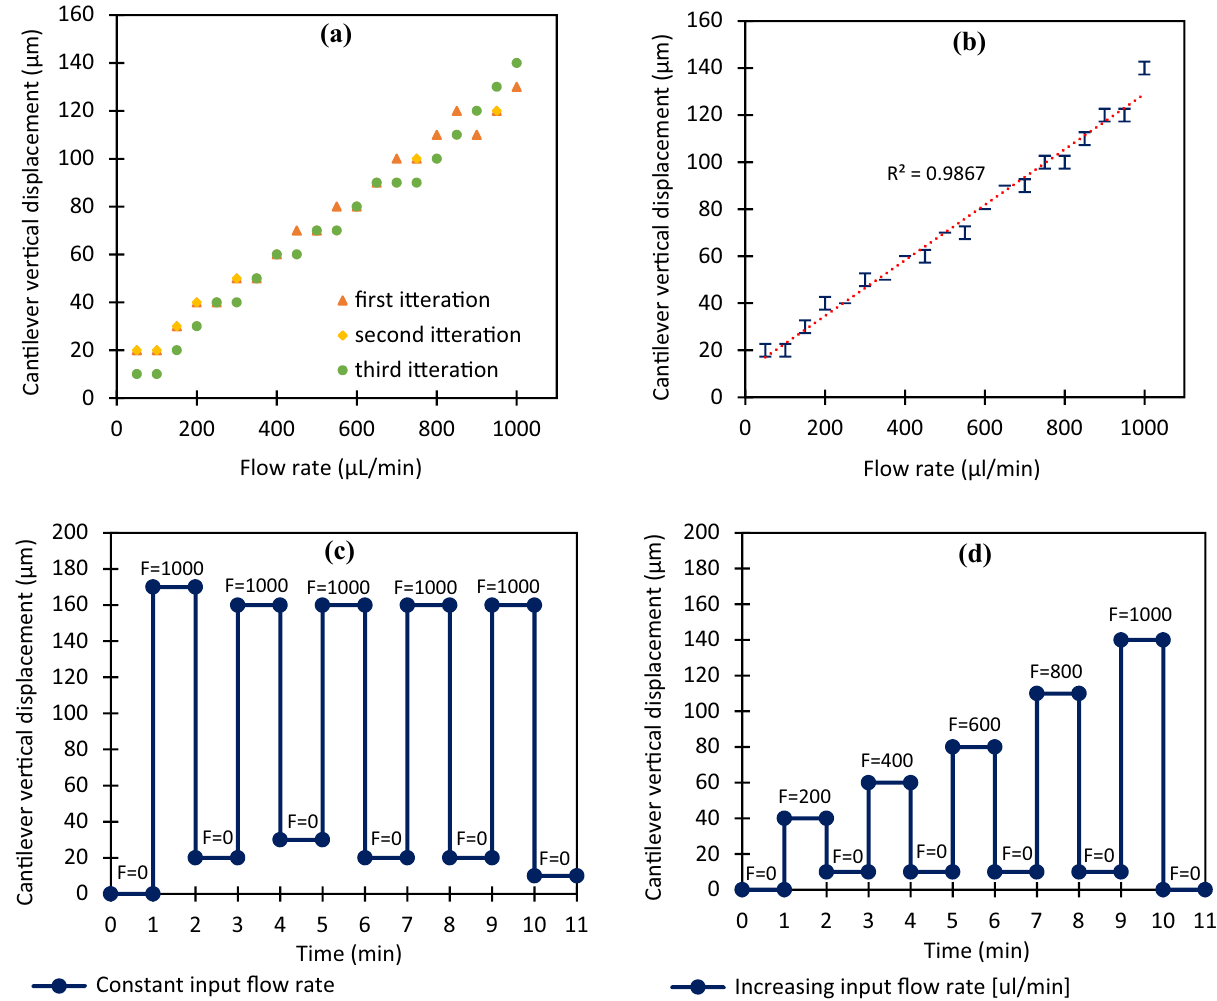
Figure 5. The value of vertical displacement of the cantilever ( a ) the observed results for three different tests and ( b ) linearization and measured error after three times of testing. ( c , d ) The sensor reversibility to initial state in consecutive use of micro flowmeter in two modes of constant and variable input